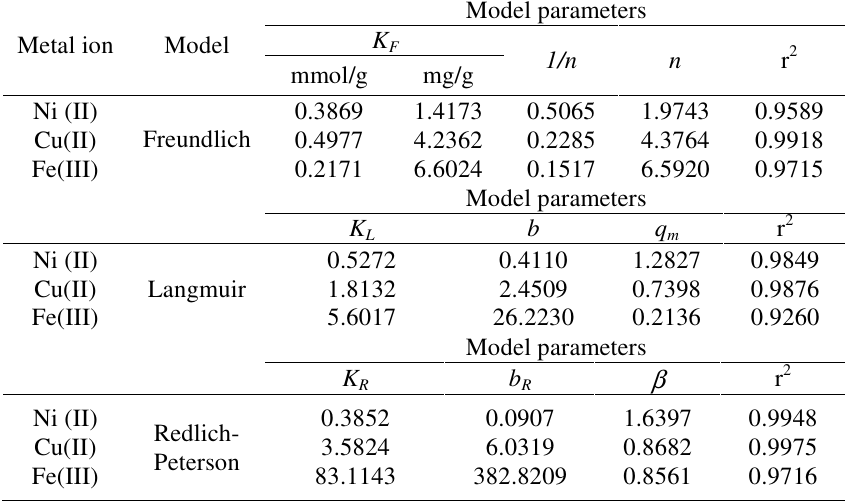
Table 2. Isotherm parameters for the adsorption of metal ions on CC